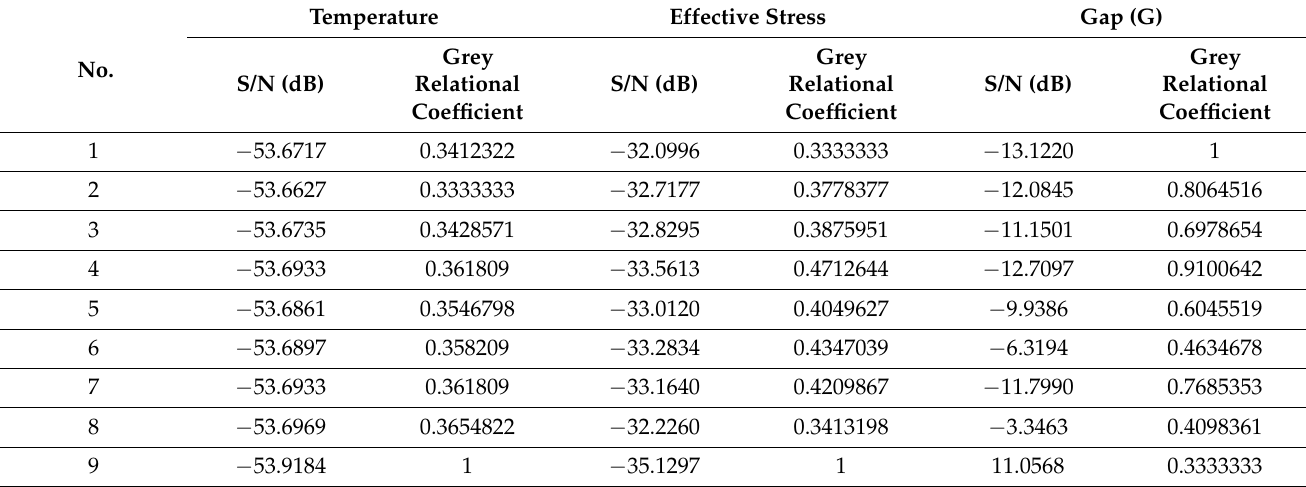
Table 9. Grey relational coefficients and S/N ratios for the three quality characteristics.